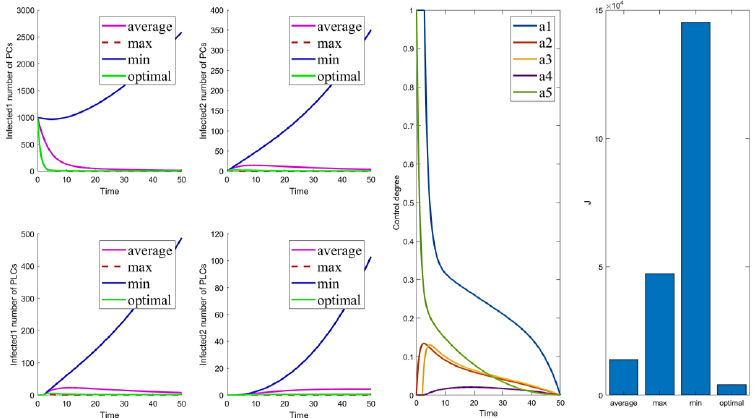
Figure 2. Solution of the optimal control strategy for Case 31.